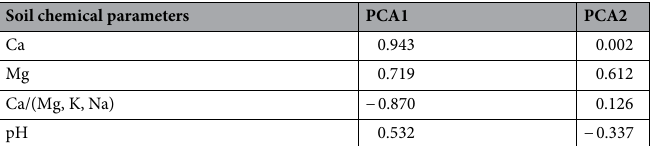
Soil chemical parameters PCA1 PCA2 Ca